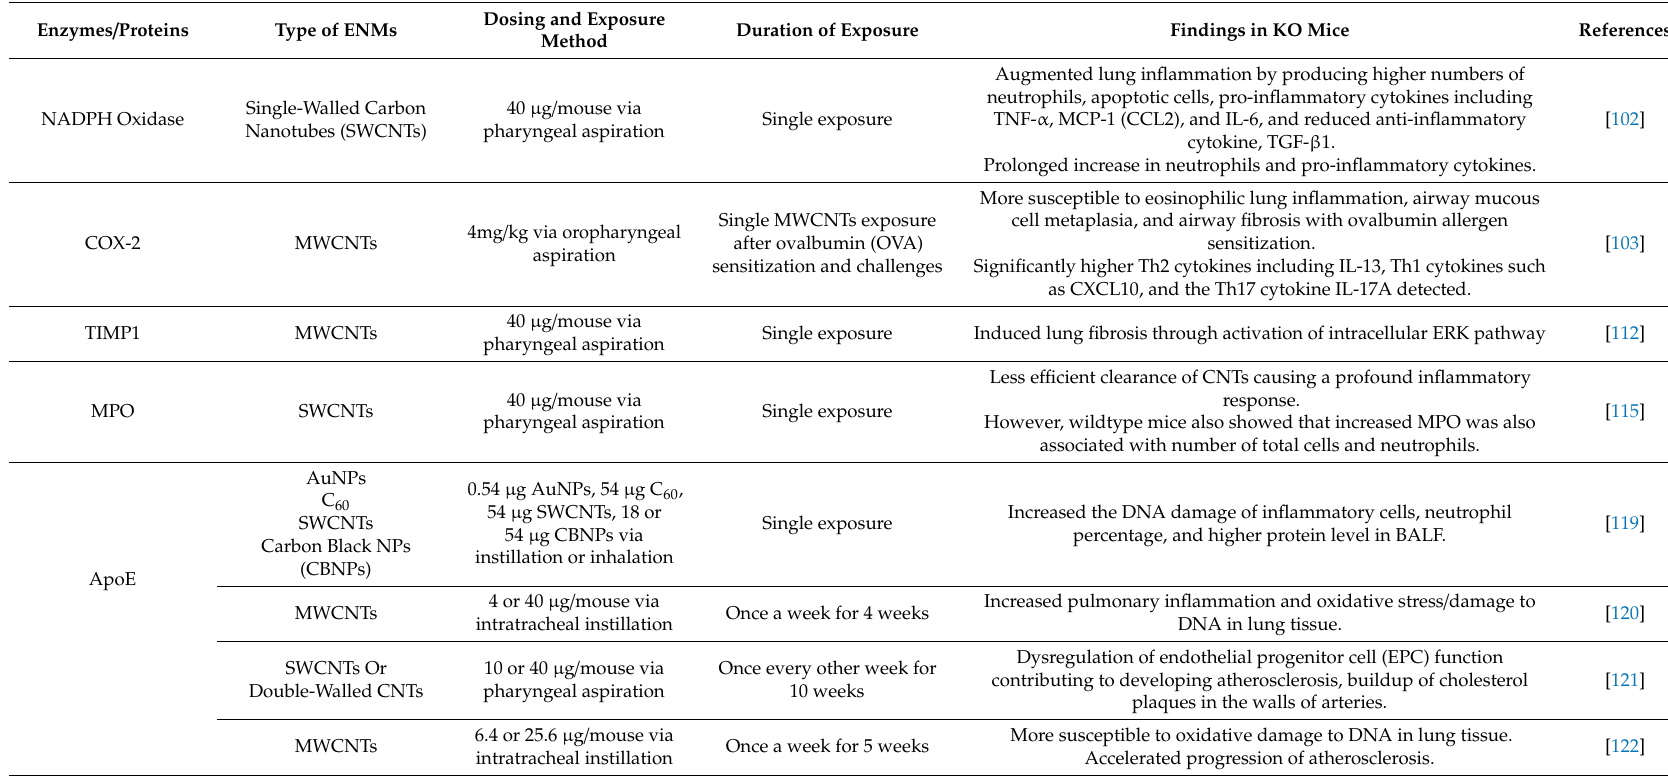
Table 2. Summarized list of enzymes / proteins that may be involved in the susceptibility to ENM-induced chronic lung